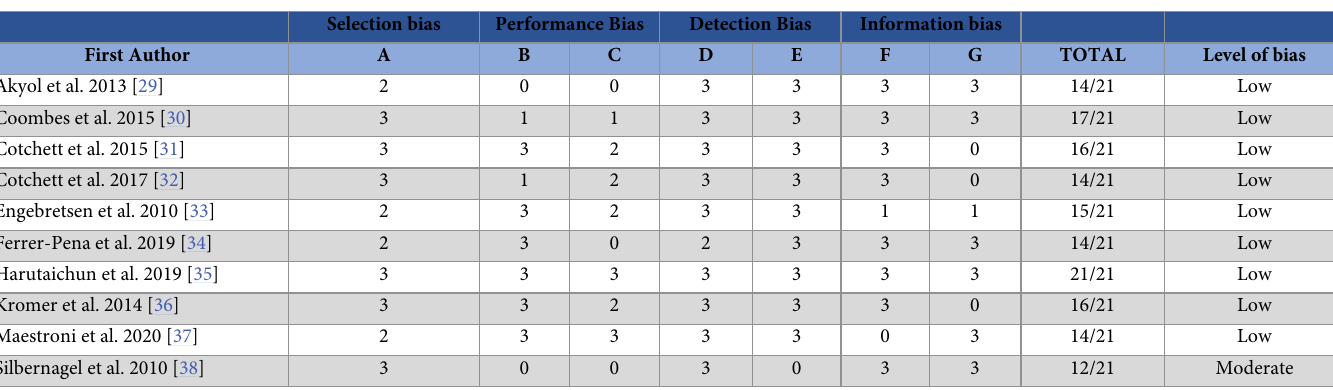
Table 3. Risk of bias (Newcastle Ottawa Scale- modified version).